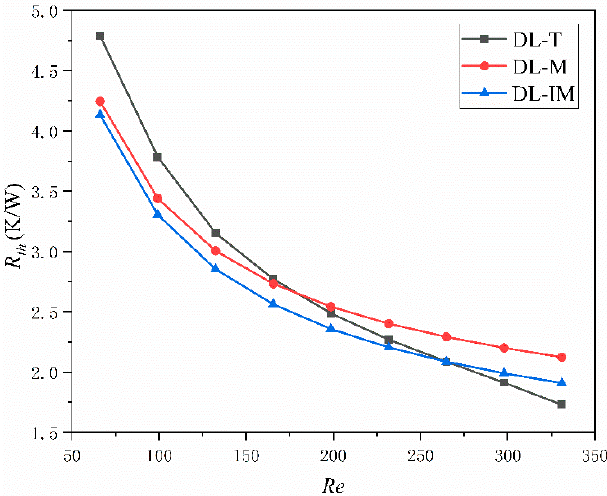
Figure 10. Thermal resistance of DL-T, DL-M and DL-IM in different Reynolds number conditions.